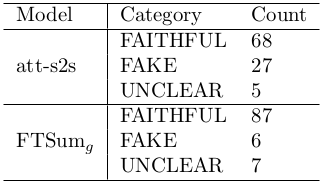
Table from the paper: Faithful to the Original: Fact Aware Neural Abstractive Summarization
Table text:
Model
Category
Count
att-s2s
FAITHFUL
68
FAKE
27
UNCLEAR
5
FTSum g
FAITHFUL
87
FAKE
6
UNCLEAR
7